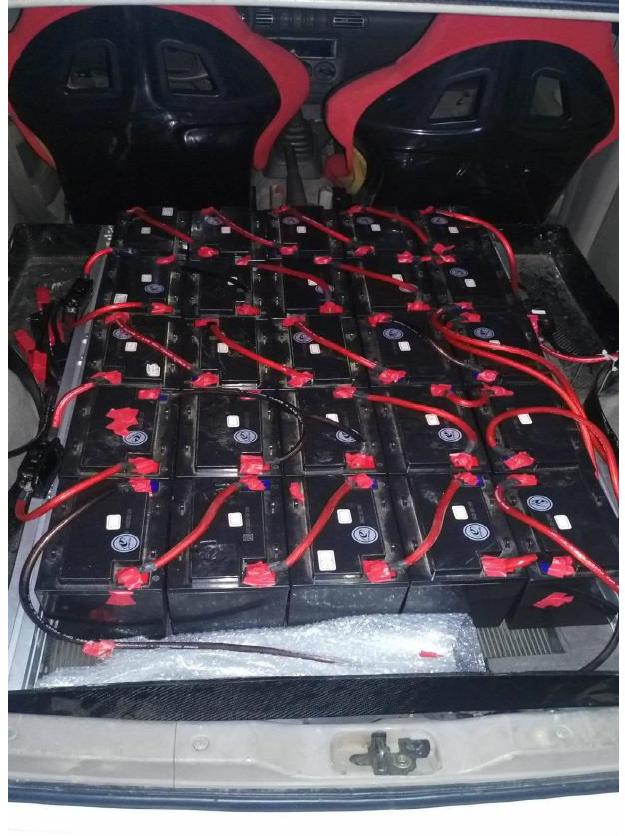
Figure 7. Twenty-five lead acid batteries assembled as the high-voltage power source.